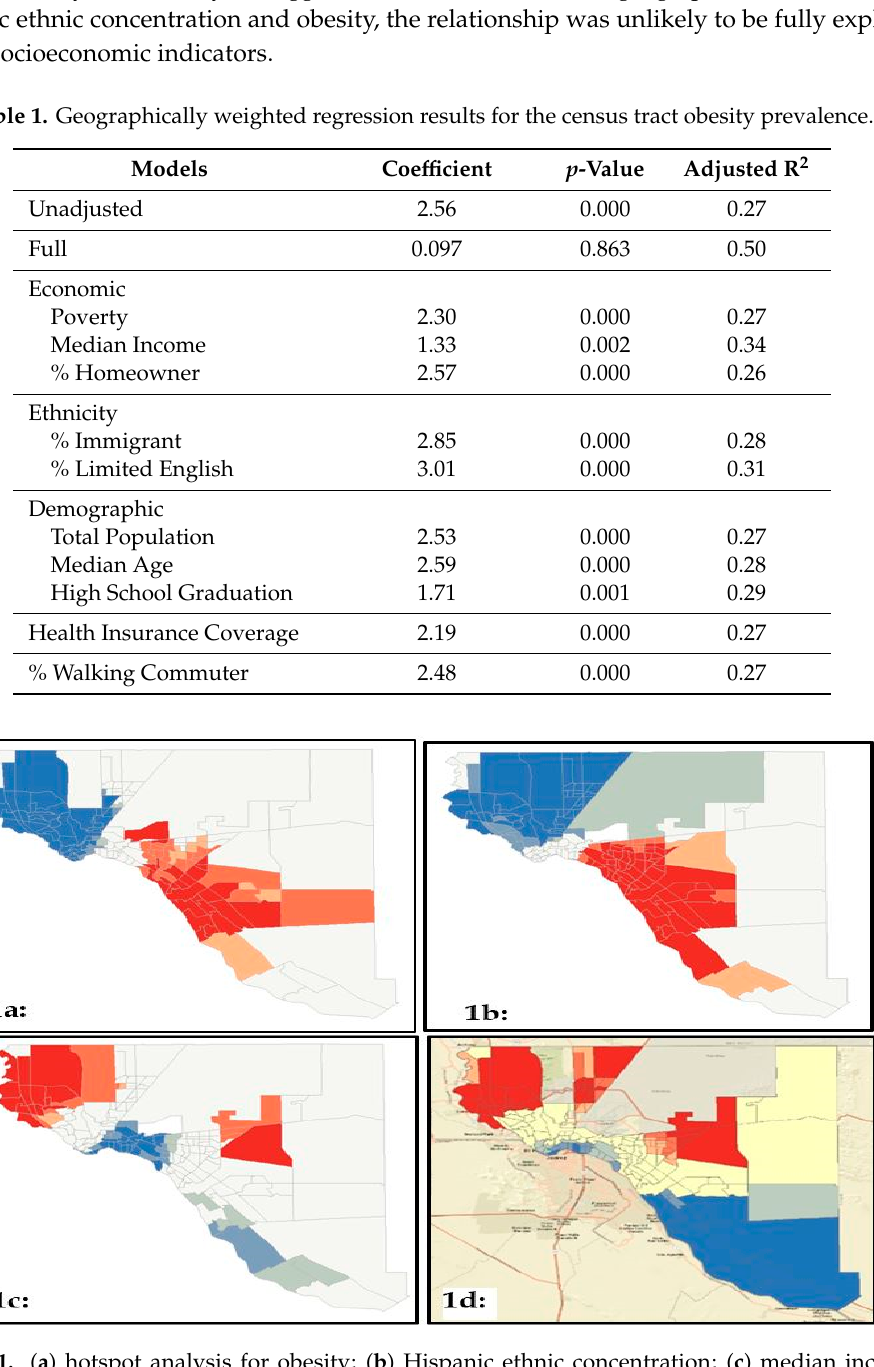
Figure 1. ( a ) hotspot analysis for obesity; ( b ) Hispanic ethnic concentration; ( c ) median income; and ( d ) high school graduation.